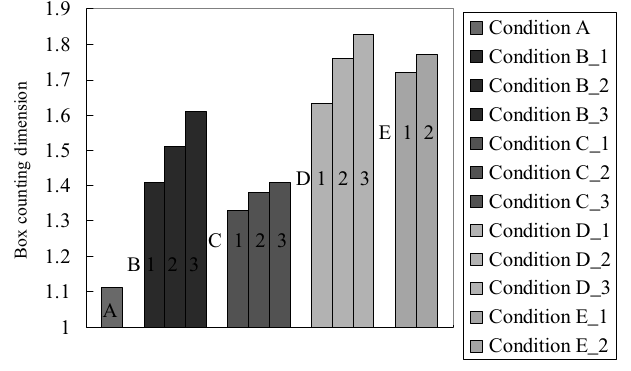
Fig. 10. Box counting dimension estimation